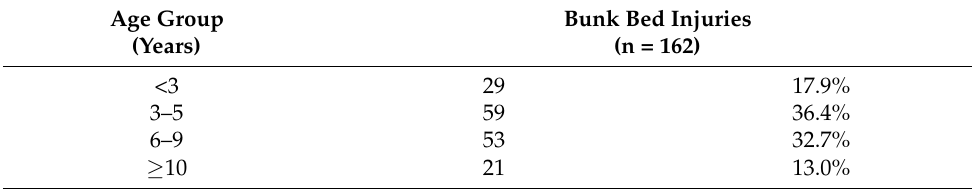
Table 1. BBR injuries in different age groups